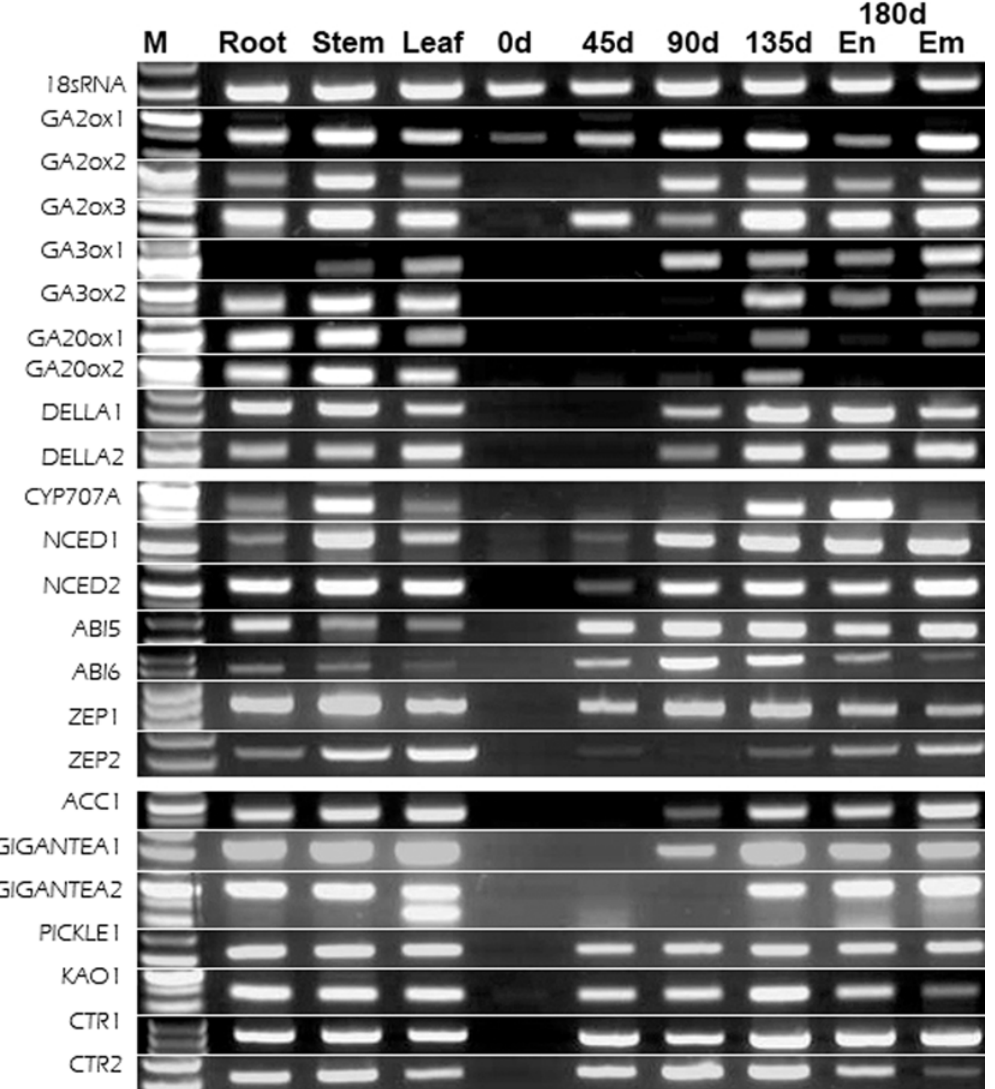
Fig 6. Semi-quantitative PCR analysis of 23 selected genes from the American ginseng seeds libraries. M: maker; 0d, 45d, 90d, 135d, and 180d: seed stratification period; Em: embryo; En: endosperm; root, stem, and leaf as control